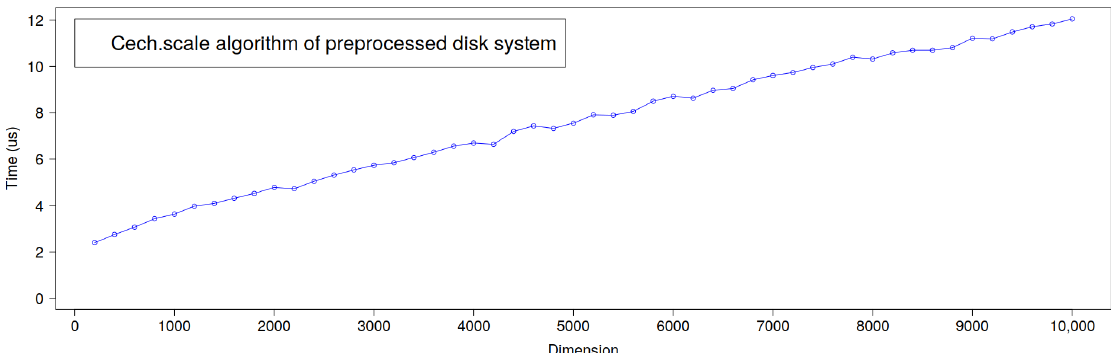
Figure 10. Average time ( µ s) in high dimensions of the Cech.scale script and preprocessing disk